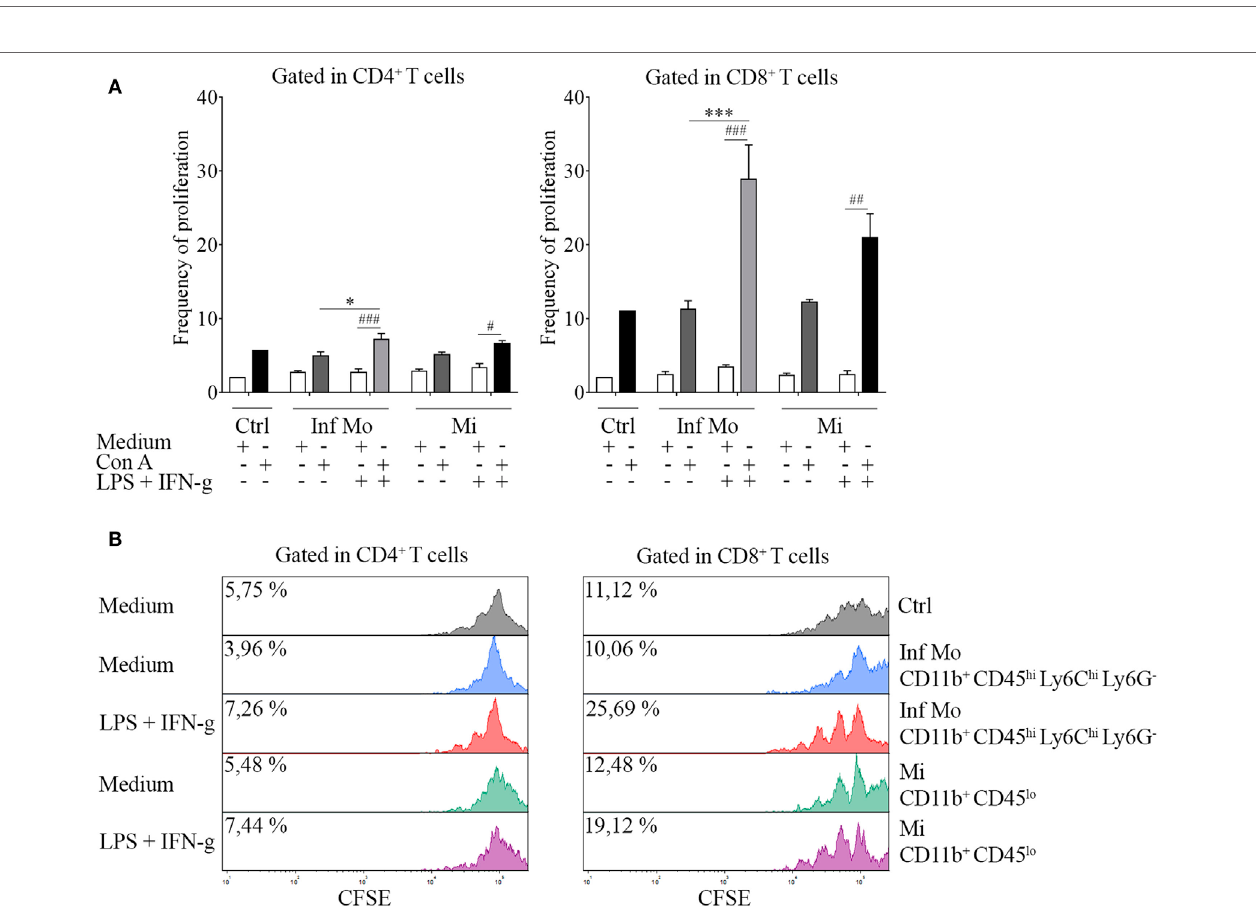
FigUre 5 | Immune function of inflammatory CD11b + CD45 hi Ly6C hi Ly6G − cells isolated after a systemic lipopolysaccharide (LPS) challenge. Mice were treated i.p. with either vehicle or 40 µg of LPS (1,6 mg/kg) for four consecutive days to induce neuroinflammation. Twelve hours post the last injection, mice were euthanized and immune cells were isolated from whole brain homogenates and labeled for subsequent cell sorting. (a) In vivo LPS-primed CD11b + CD45 hi Ly6C hi Ly6G − inflammatory monocytes or CD11b + CD45 lo microglial cells isolated by cell sorting from a pool of mice brains were cocultured with CFSE (4 µM)-labeled naïve splenocytes at a 1:1 ratio (1 × 10 5 cell/mL) in the presence or absence of concanavalin A (Con A) (5 µg/mL). Cells from endotoxemic mice were challenged or not ex vivo with LPS (100 ng/mL) plus IFN-g (20 ng/mL) cocktail prior to the coculture. T cell frequency of proliferation was examined after 72 h by CFSE dilution through flow cytometry. Results are representative of two independent experiments combined ( n = 17–20 animals). (B) Representative stacked histograms depicting CFSE dilution. Data are expressed as mean ± SEM. Ctrl, control; Inf Mo, inflammatory monocytes; Mi, microglial